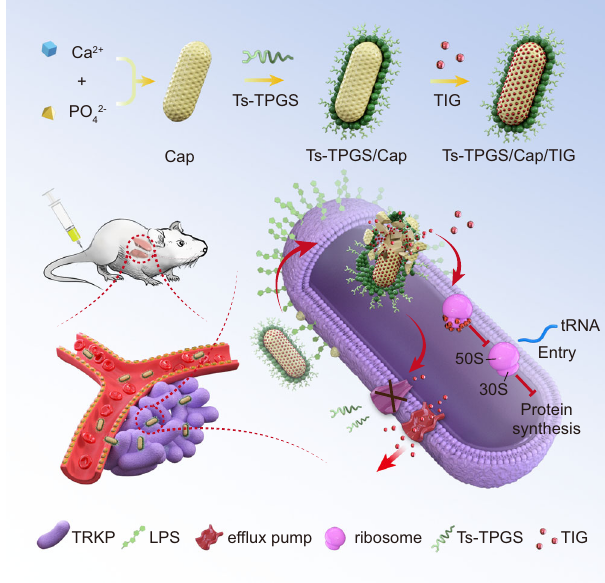
Fig. 1 Schematic depiction of the fabrication of the nanorods and the mechanism of overcoming the tigecycline resistance of TRKP.